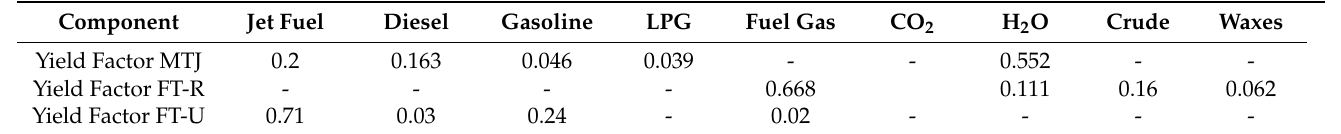
Table 2. Yield factors for Fischer–Tropsch reaction + upgrading as well as methanol-to-jet process (data from